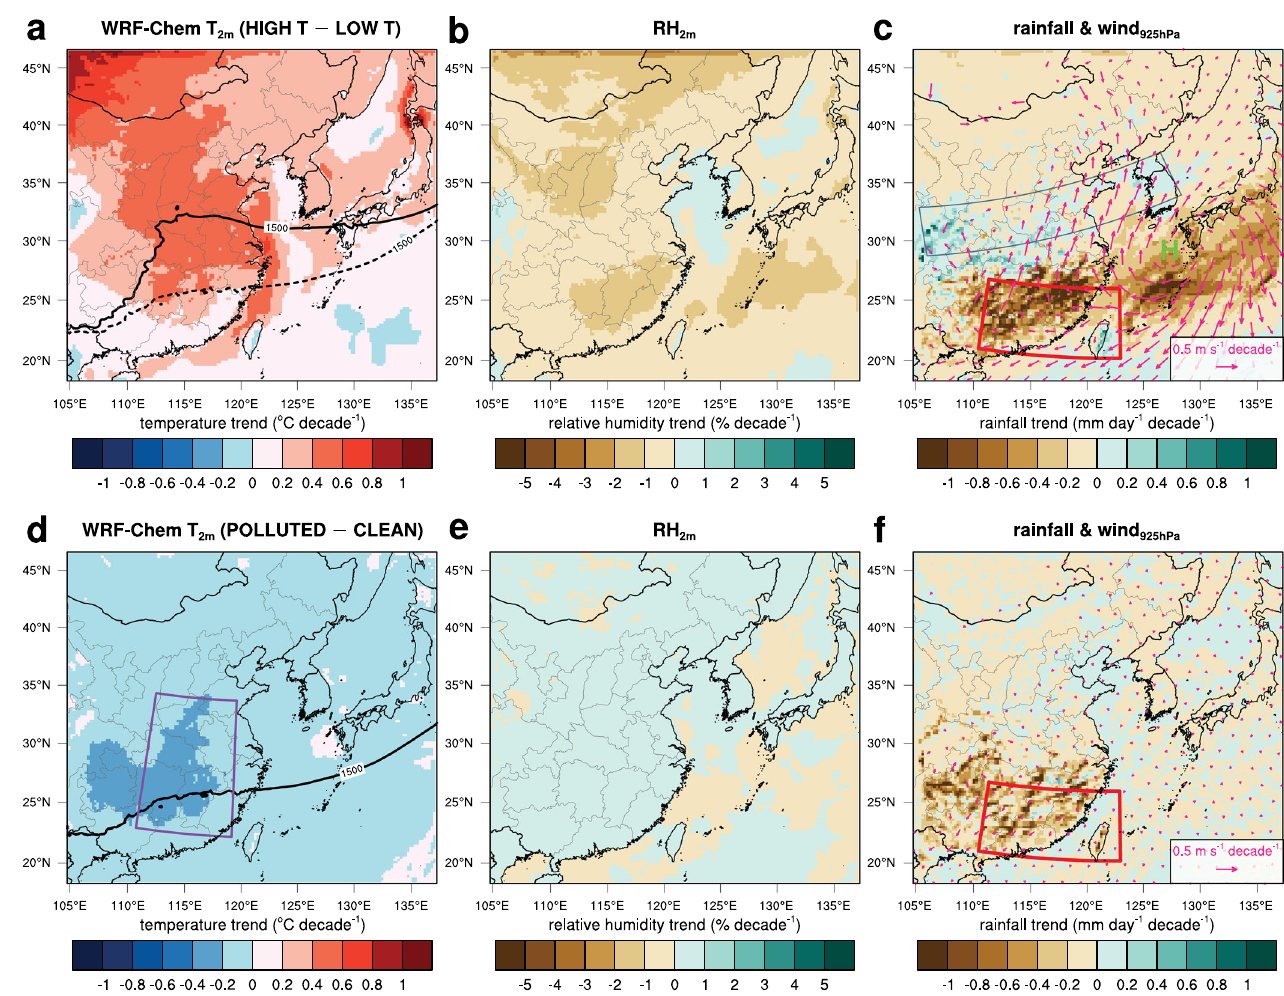
Fig. 2 Effects of warming and aerosols from WRF-Chem simulations. Scaled trends in March – April mean ( a ) temperature at 2 m, ( b ) relative humidity at 2 m, c daily rainfall and 925 hPa winds. Note that the differences in the variables between the HIGH T_CLEAN and LOW T_CLEAN simulations in 2018 are divided by 50 years, and these values are referred to as the scaled trends. In a , the geopotential height of 1500 m at 850 hPa in the HIGH T_CLEAN (LOW T_CLEAN) simulation is highlighted by thick sold (dashed) line. d – f are the same as in ( a – c ) but compare HIGH T_POLLUTED and HIGH T_CLEAN simulations.